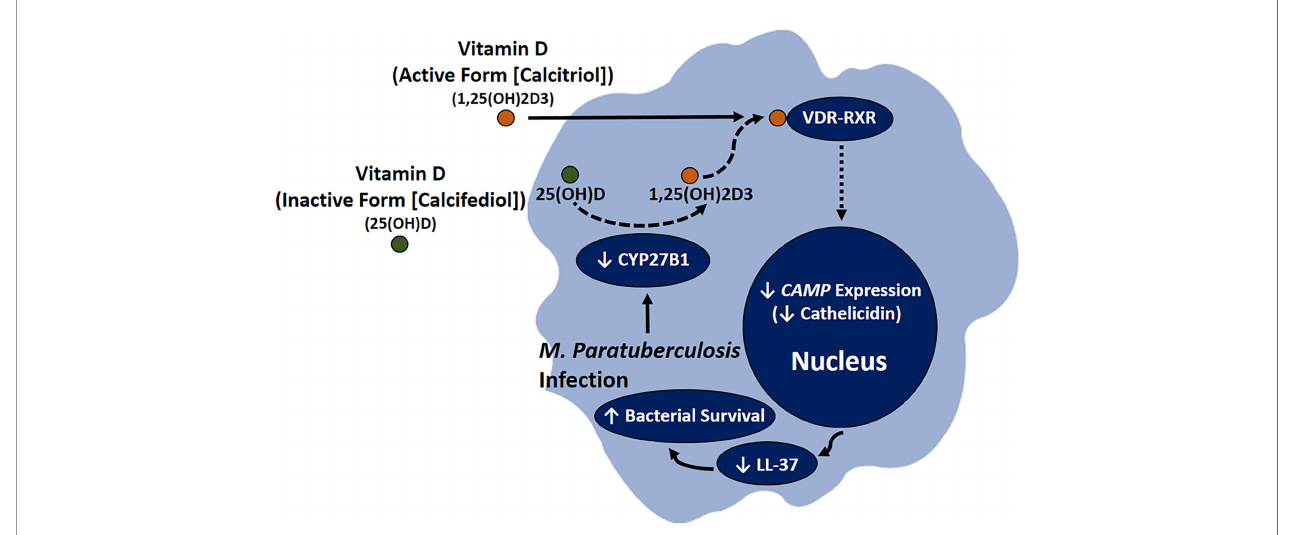
FIGURE 12 | Role of MAP infection in CD pathogenesis through downregulating the conversion of calcifediol to calcitriol, resulting in lower CAMP expression, which leads to reduction in LL-37 production and increased bacterial viability in infected